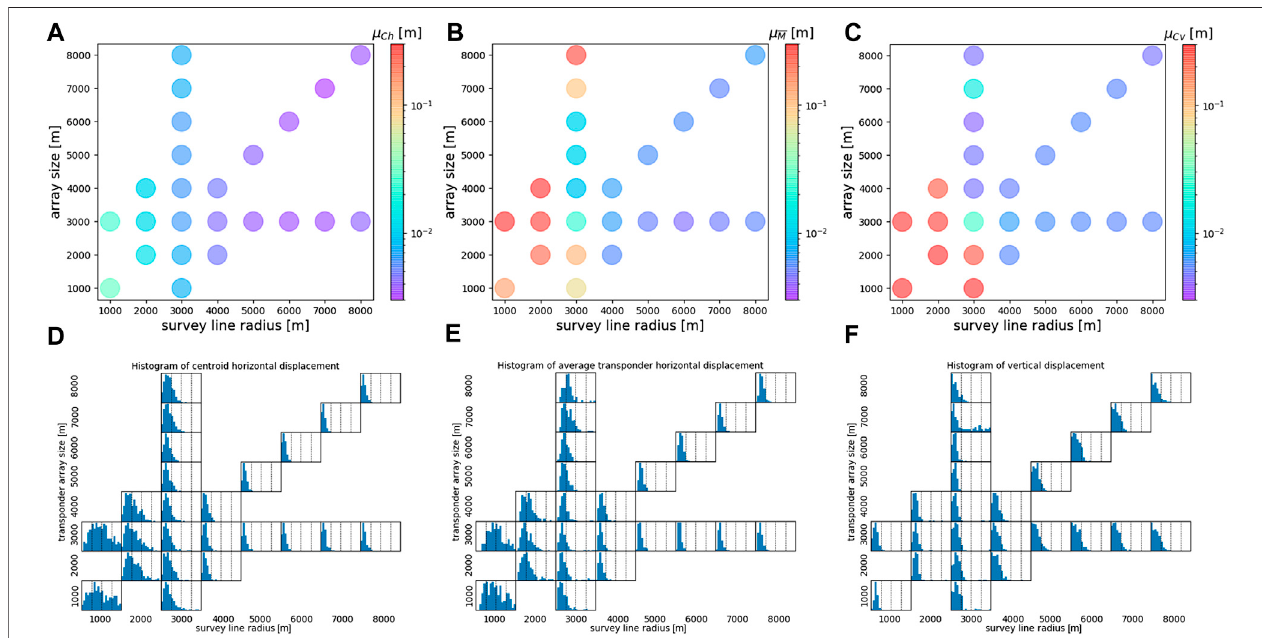
FIGURE4| Theresultsofthenumericalexperiments.Figure (A) istheplotoftheaveragehorizontalerrorofthecentroid μ Ch , (B) istheplotoftheaveragehorizontal error ofthefourtransponders μ , (C) istheplotoftheaveragevertical errorofthecentroid μ Cv .Figure (D) isthehistogramofthehorizontal errorofthecentroidobtained M from 300 trials for each experimental run, (E) is the histogram of the average horizontal error of the four transponders, and (F) is the histogram of the vertical error of the centroid. The range of these histograms are from 0 cm to 4 cm, and the dashed lines indicate 1 cm intervals. Note that Figures (D) , (E) , and (F) have outliers that exceed 4